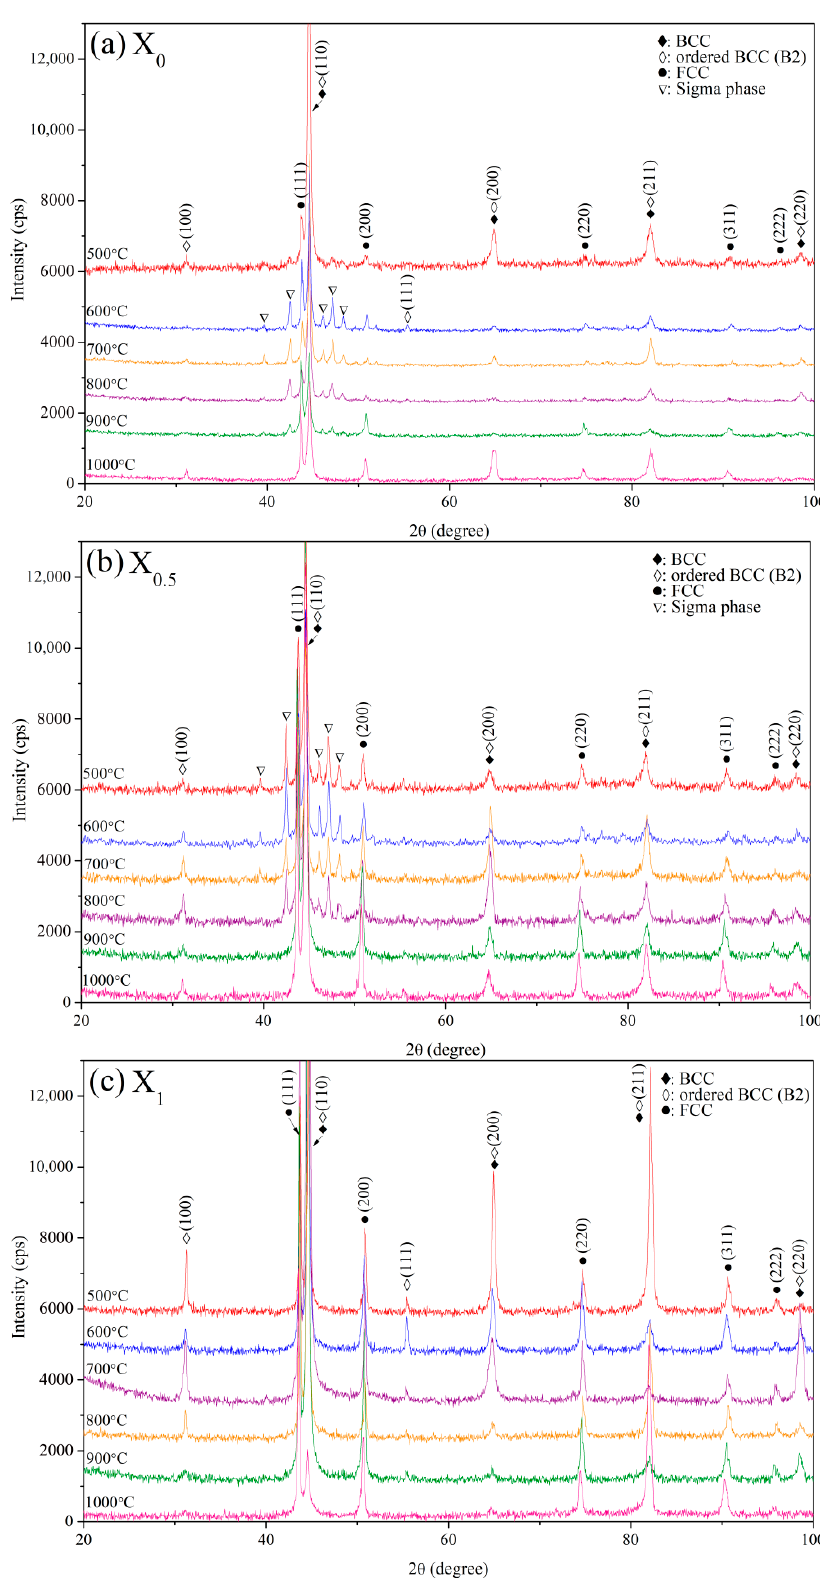
Figure 15. XRD patterns of the three as-cast alloys after aging at 500–1000 °C for 144 h: ( a ) X 0 ; ( b ) X 0.5 ; and ( c ) X 1 .